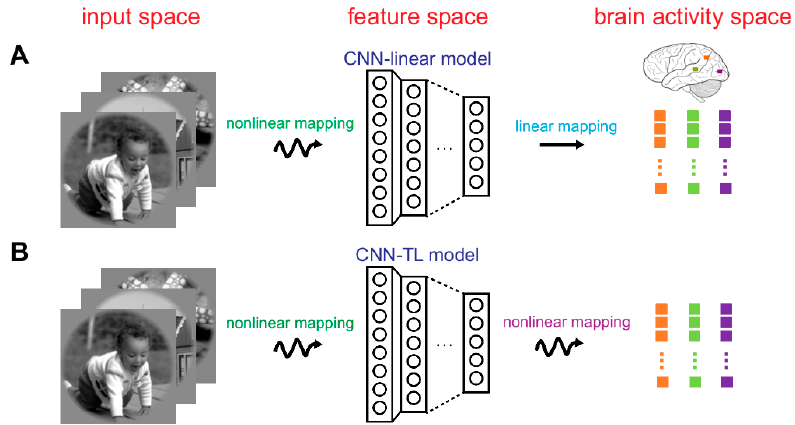
Figure 2. Visual encoding models. ( A ) The CNN-linear model. The first step is a nonlinear mapping that a pre-trained CNN (i.e., AlexNet) represents image features to construct the feature space. The second step is the linear mapping from the feature space to the brain activity space. In the brain activity space, di ff erent colored dots represent the responses of di ff erent voxels. Each dot represents the response of a voxel to one image. ( B ) The CNN-TL model. The first step is the same as that of CNN-linear model, but the second step is the nonlinear mapping, achieved by transfer learning.